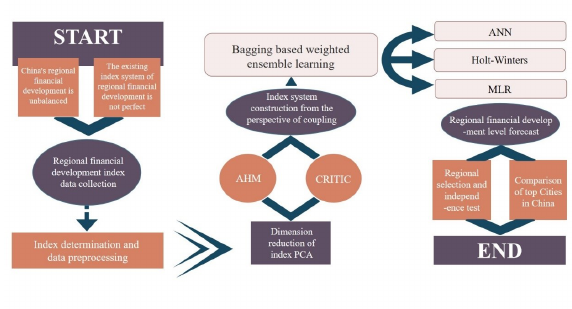
Fig. 1. Construction of Regional Financial Development System and Forecasting